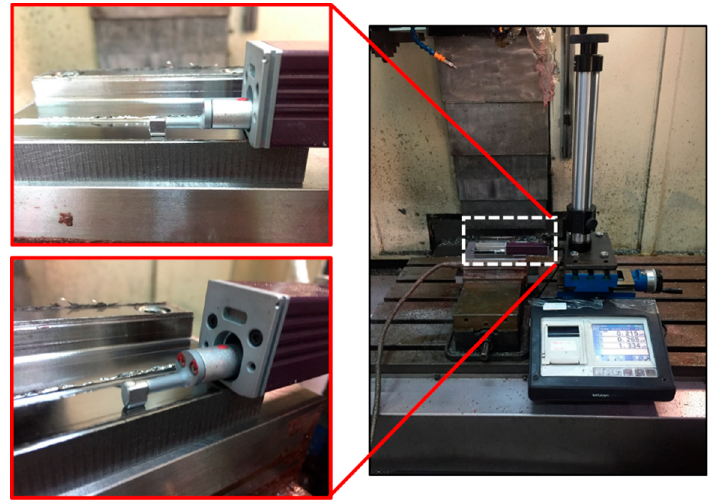
Figure 5. Image of Ra measurement moment.